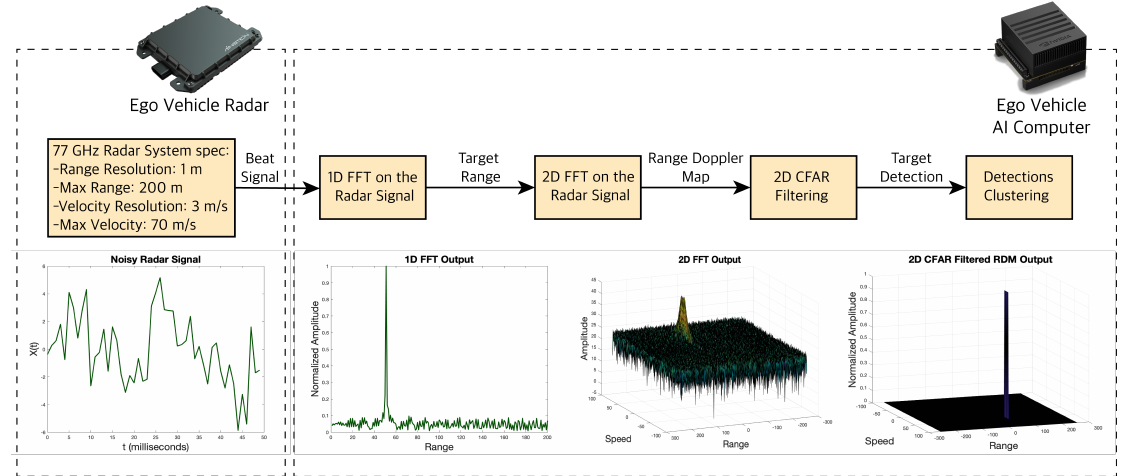
Figure 9. Radar data processing pipeline. Plots from left to right: Noisy radar beat signal, output of the 1D-FFT showing a detection with its range, output of the 2D-FFT showing a detection with its range and Doppler velocity, and output of the 2-Dimensional Constant False Alarm Rate (2D-CFAR) filtering showing the detection with noises filtered